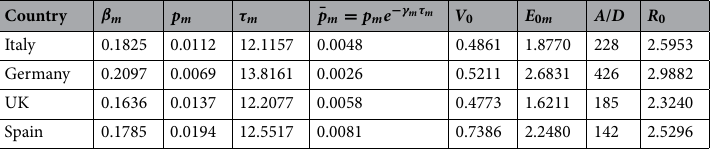
Table 3. Parameter sets from mean- β model yielding the lowest E 0 m , and subsidiary